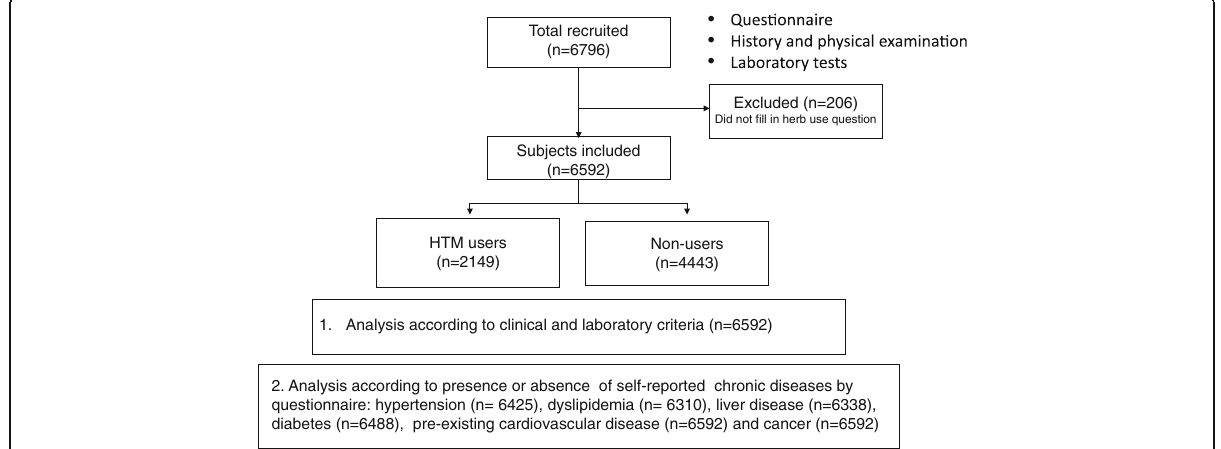
Fig. 1 Flow of the study participants according to herb usage in the health questionnaire. HTM users, herb and traditional medication